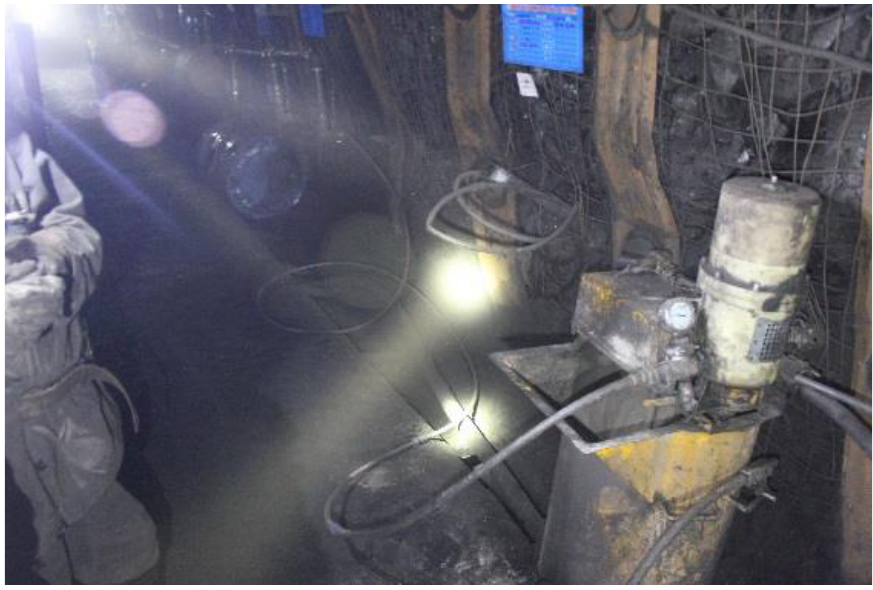
Figure 13. The entity of grouting.